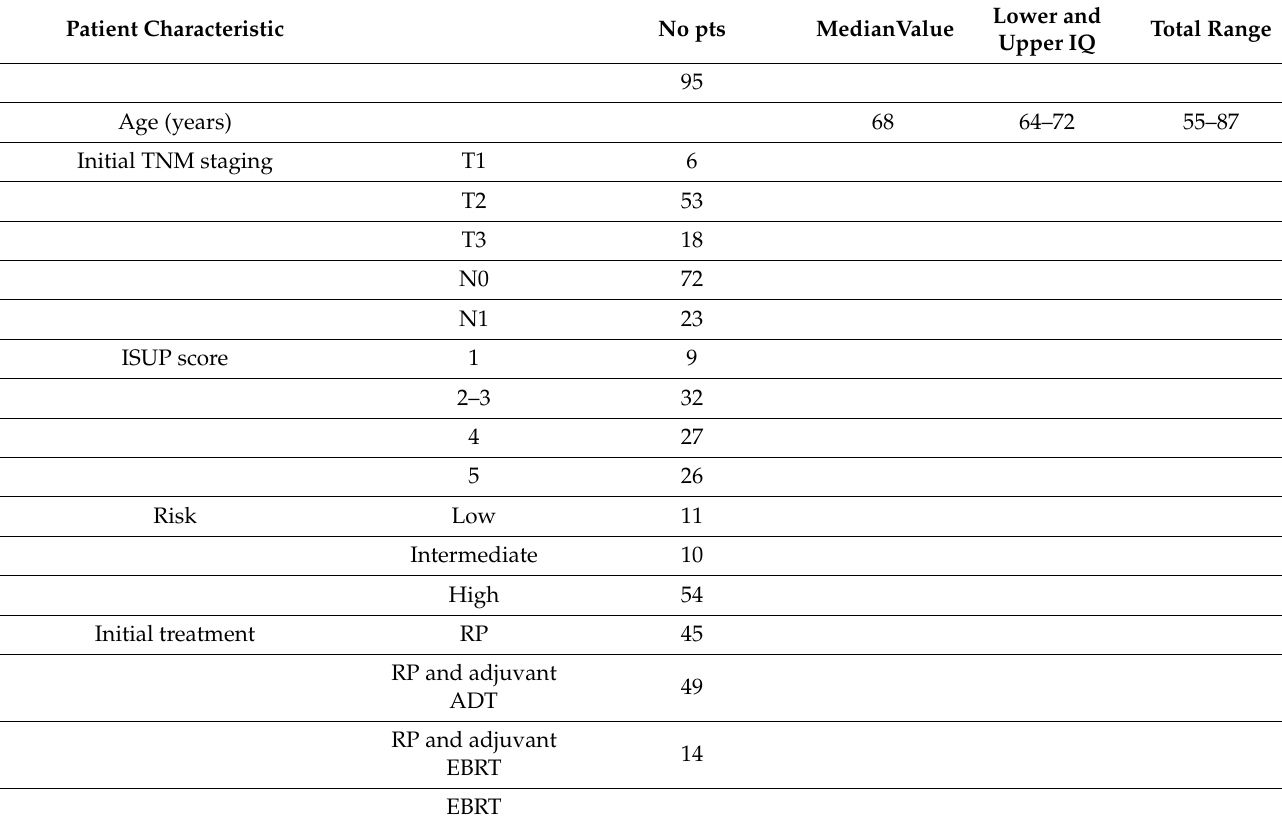
Table 1. Patient